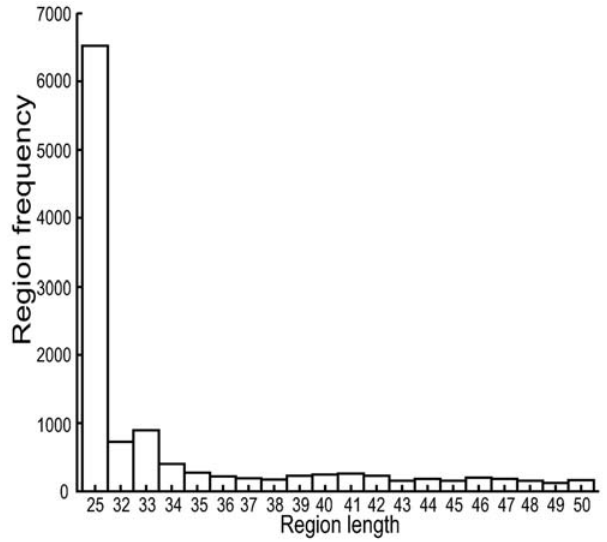
Figure 7. Distribution of short similarly expressed regions. Distribution plot of all similarly expressed regions ( , =50 nts in length) in the DMSO and the MNNG dataset